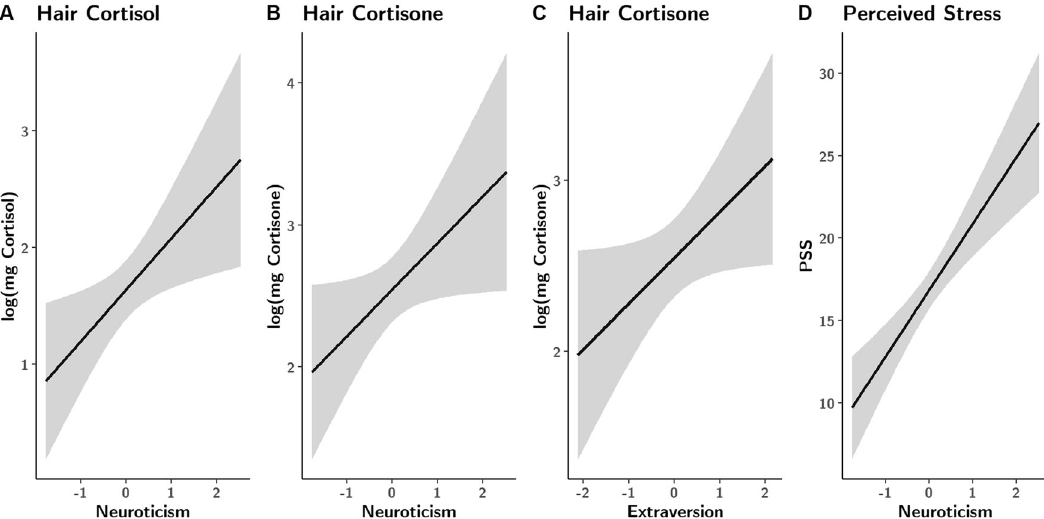
Fig. 3 Fixed effects of multiple regression covariates. Estimated effects (and SD) of neuroticism and extraversion on hair cortisol ( A ), hair cortisone ( B , C ) and PSS scores ( D ). Neuroticism revealed positive associations across all stress markers, suggesting increasing physiological and subjective strain with increasing neuroticism. Extraversion had a signi fi cant effect on hair cortisone, also revealing a positive